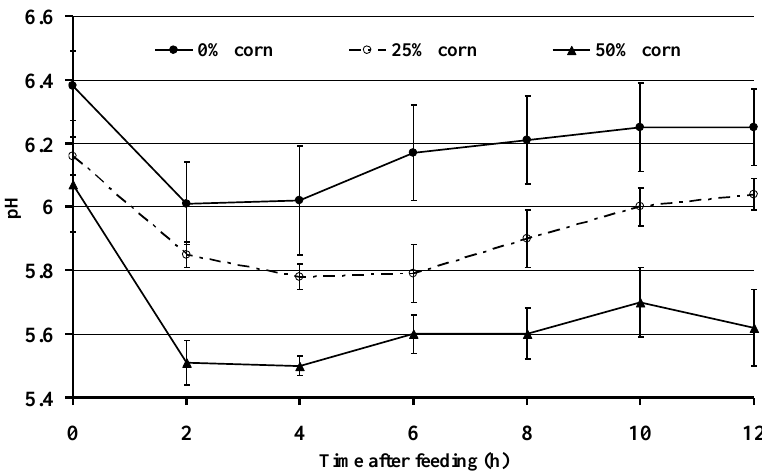
Figure 1. The daily rumen pH variation during the 12 h after morning feeding (n =